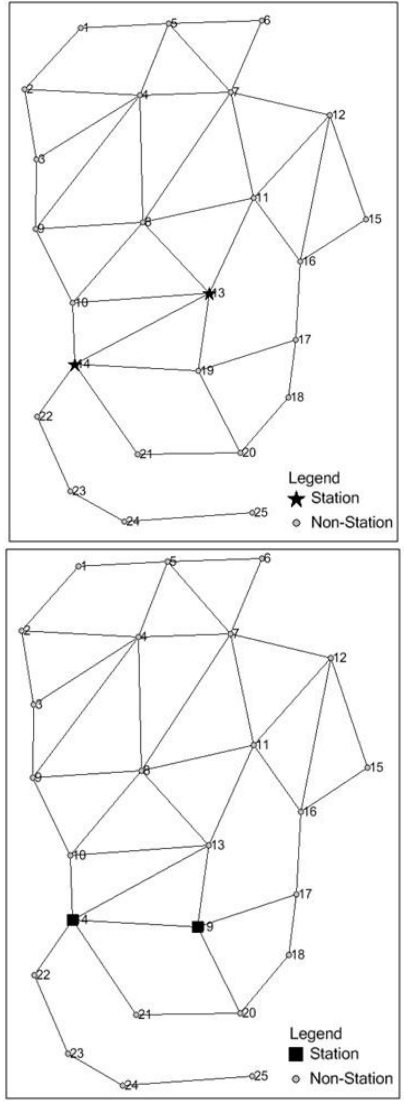
Fig.3 Location Results of FCLM